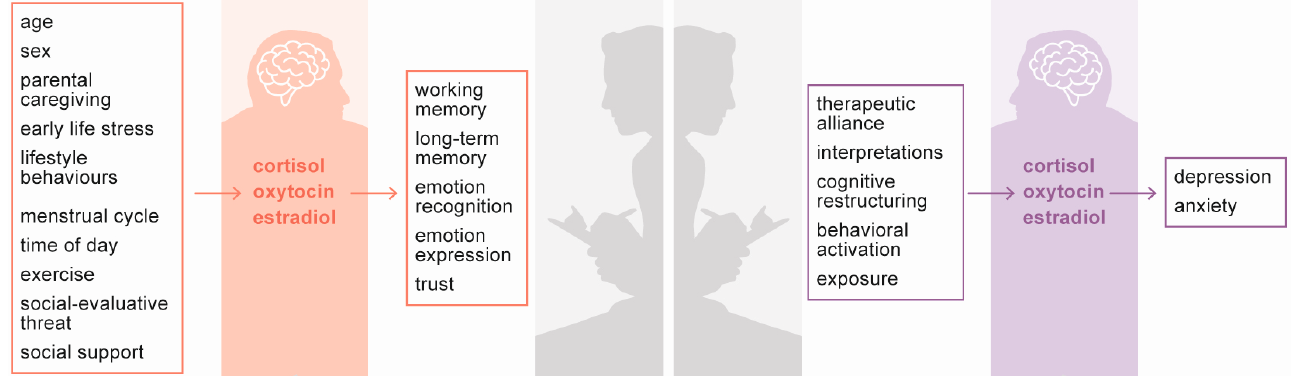
Figure 2. Illustration of how hormones may affect psychotherapy and vice versa. Hormonal determinants and relevant domains of cognitive-behavioural functioning are depicted on the left, whereas relevant therapeutic interventions/processes and outcomes are depicted on the right.